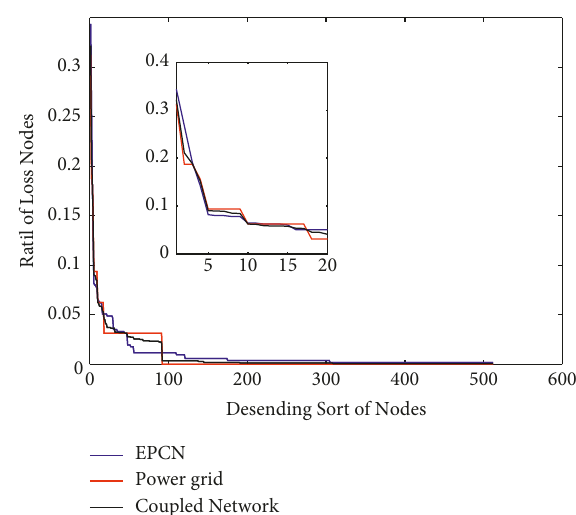
Figure 10: Rln of cyber nodes of three